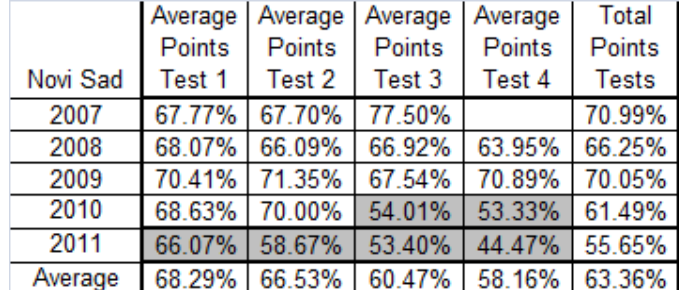
Test Points for Novi Sad Students of Computer